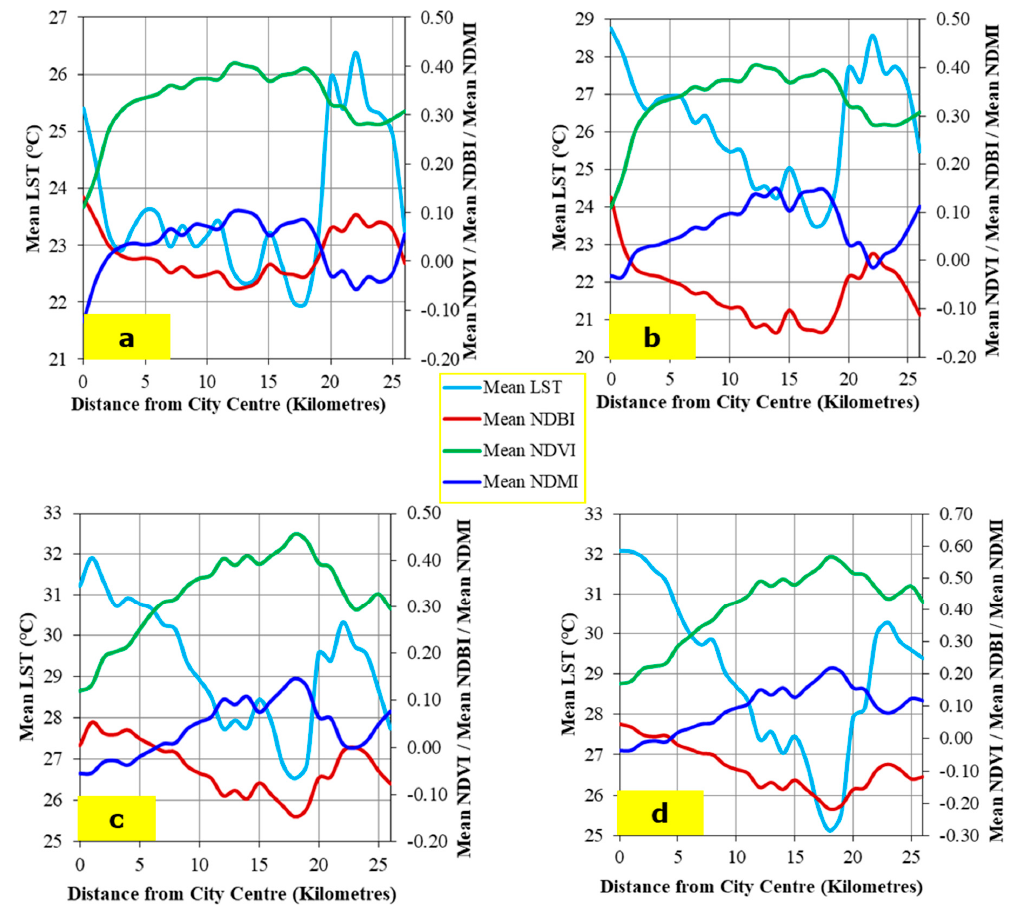
Figure 10. Estimates of LST, NDVI, NDBI, and NDMI across an urban to rural transect across Kathmandu to portray the SUHI dynamics, ( a ) 1988; ( b ) 1998; ( c ) 2008; ( d ) 2018.